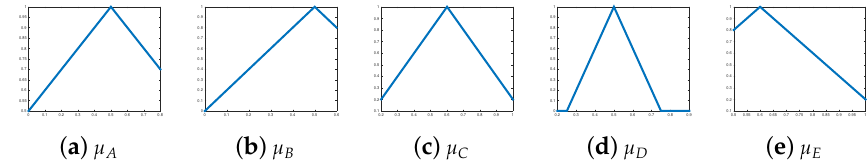
Figure 6. Membership functions of partial fuzzy sets from Example